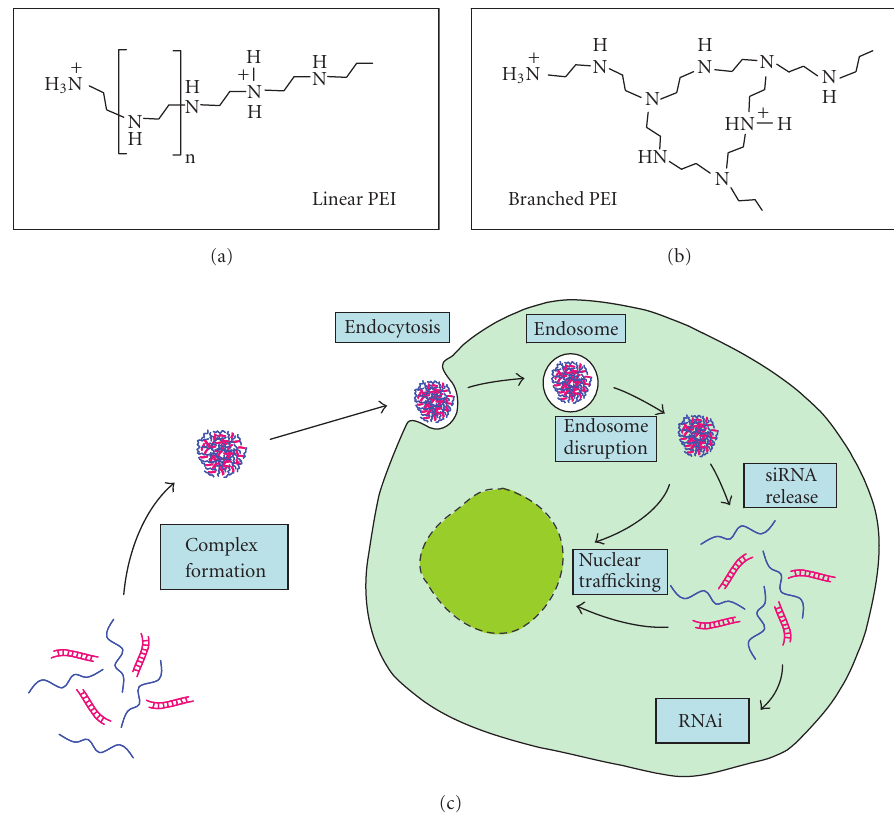
Figure 2: Polyethylenimine (PEI)-mediated siRNA transfer. Upper panel: PEIs are synthetic linear (a) or branched (b) polymers with an amino group in every third position. Dependent on the pH, some of these amino nitrogens are protonated giving PEI a high cationic charge density. Lower panel: proposed mechanism of PEI-mediated siRNA transfer. Due to electrostatic interactions, PEI is able to complex negatively charged siRNAs leading to a compaction and the formation of small colloidal particles which are endocytosed. The “proton sponge e ff ect” exhibited by PEI complexes leads to osmotic swelling and ultimately to the disruption of the endosomes. siRNAs are protected from degradation due to their tight condensation in the complex and the bu ff ering capacity of PEI. Upon their release from the PEI-based complex, intact siRNAs are incorporated into the RISC complex and induce RNAi (see Figure 1).